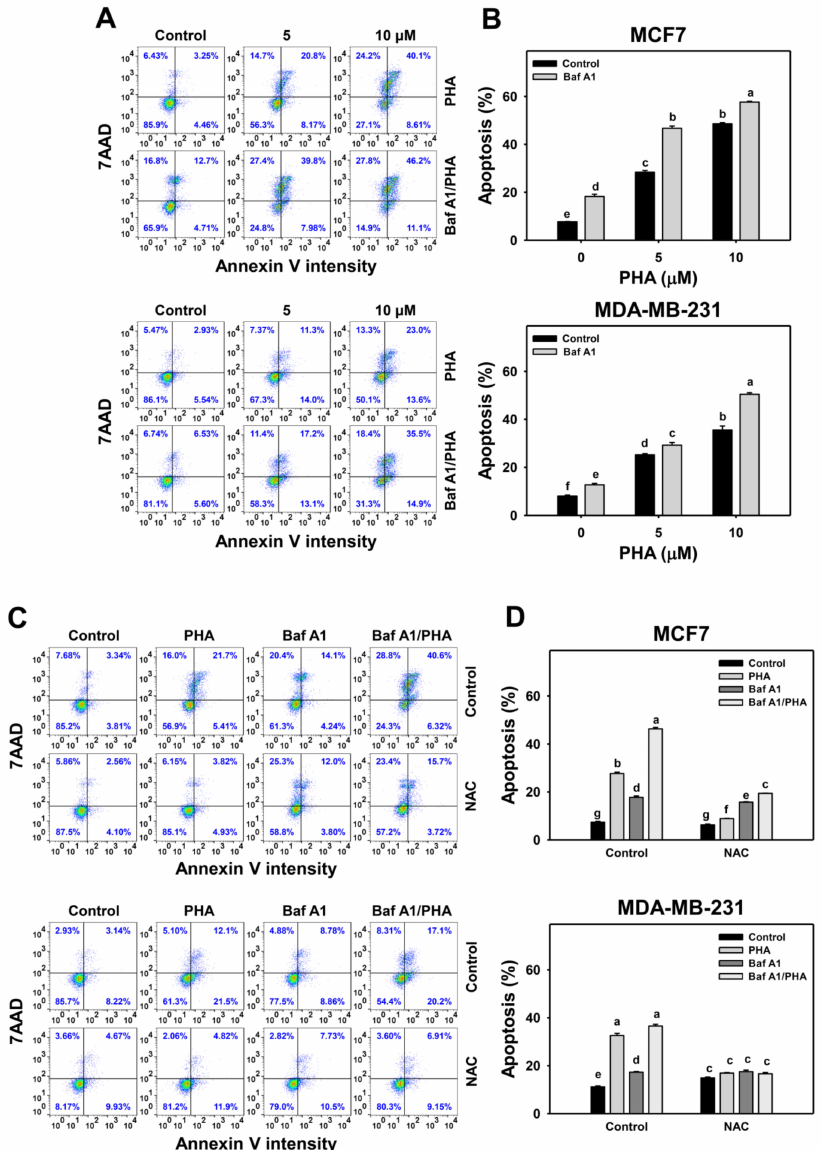
Figure 6. Autophagy downregulation increases the PHA-induced annexin V level in breast cancer cells. ( A , B ) Annexin V/7AAD detection. Cells were co-treated with PHA (0 (control), 5, and 10 µ M) and Baf A1 (0 (control) and 100 nM) for 24 h. Annexin V (+)/7AAD (+/ − ) events indicate apoptosis (+) (%). ( C , D ) The impact of NAC effect on PHA-induced apoptosis. Cells were pretreated with NAC (10 mM for 1 h) and then co-treated with PHA (control and 5 µ M) and Baf A1 (control and 100 nM) for a 24 h treatment, namely Baf A1/PHA. Data, means ± SDs ( n = 3). Data with non-overlapping lower-case letters differ significantly ( p < 0.05 to